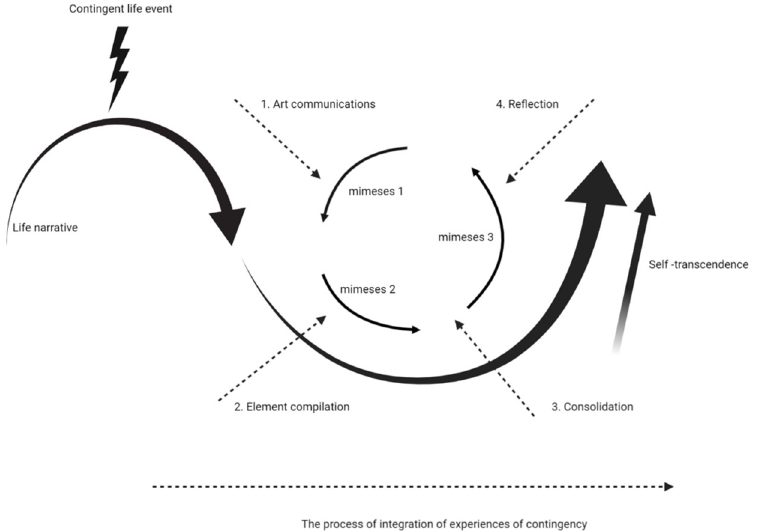
Fig 3. The position of co-creation within the theoretical framework. Co-creation consists of four distinct phases (Art communication, Element compilation, Consolidation, Reflection) which support certain aspects of the reworking and integration of a contingent life event into the life story, i.e. the integration of an experience of contingency as described in mimesis. The arrows indicate where the phases of co-creation affect the mimesis process, and thereby support the process of integration of experiences of contingency as described in the mimesis process. In both co- creation and mimesis, people can jump back and forth between phases, thus leading to an iterative process. Self- transcendence facilitates the patient to move towards more fluidity in the life narrative, enabling the integration of experiences of contingency.